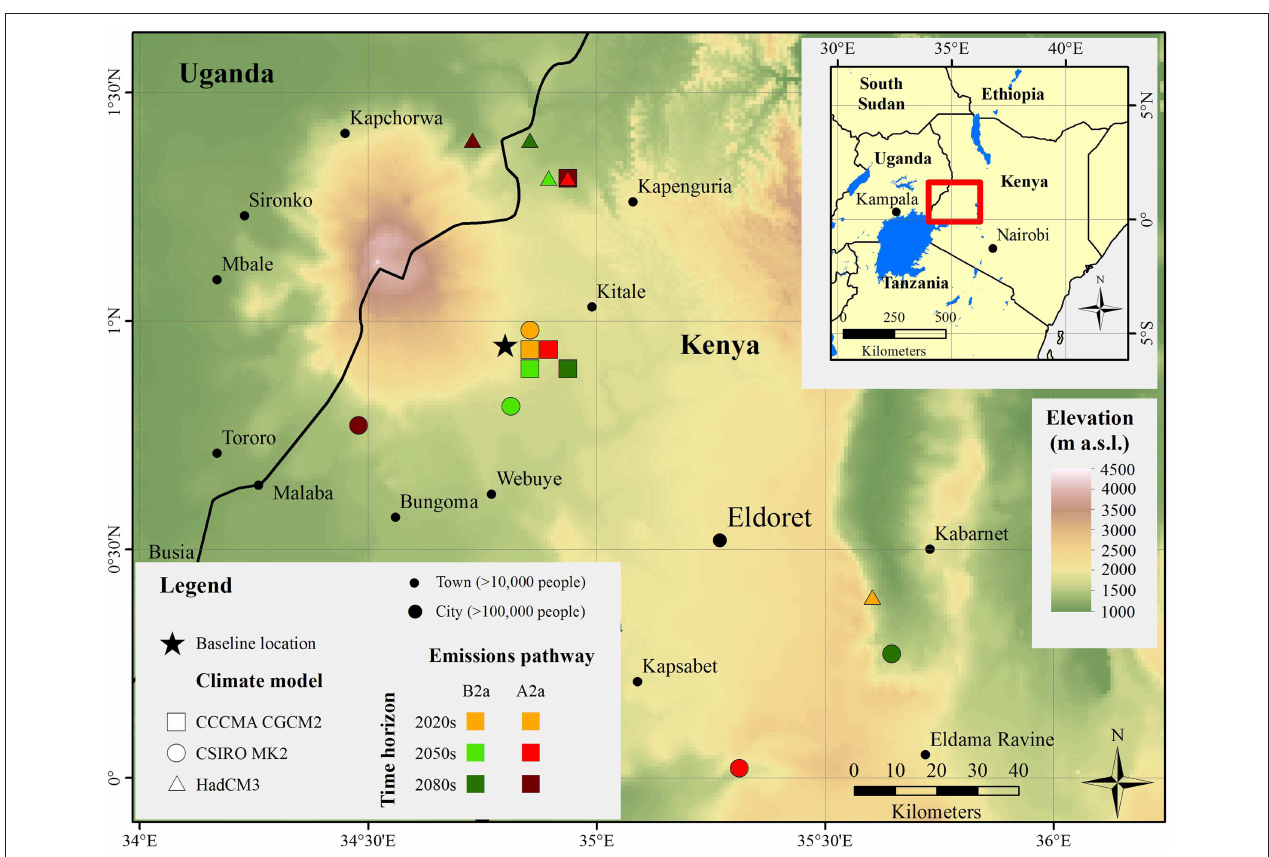
FIGURE 6 | Location of climate analogs corresponding to climate projections for two greenhouse gas emissions scenarios, three time horizons, and three climate models, along with the location of the baseline location. The analog location used for the site comparison is represented by the red square (CSIRO MK2, A2a, 2050s). Inset: location of the study area in Western Kenya. Note that analog locations for the 2020s scenarios are co-located among emissions scenarios for all climate models and therefore not distinguished by different colors. Shading indicates elevation above mean sea level, according to the GTOPO30 dataset ( USGS,